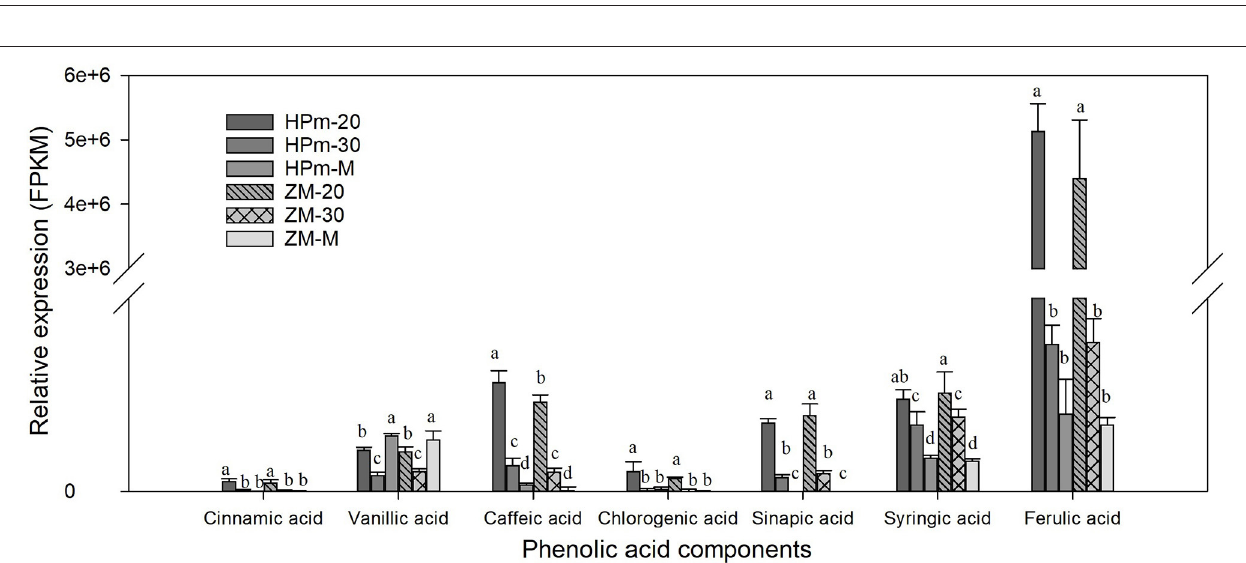
FIGURE 1 | The number of identified phenolics in wheat grains during grain development.